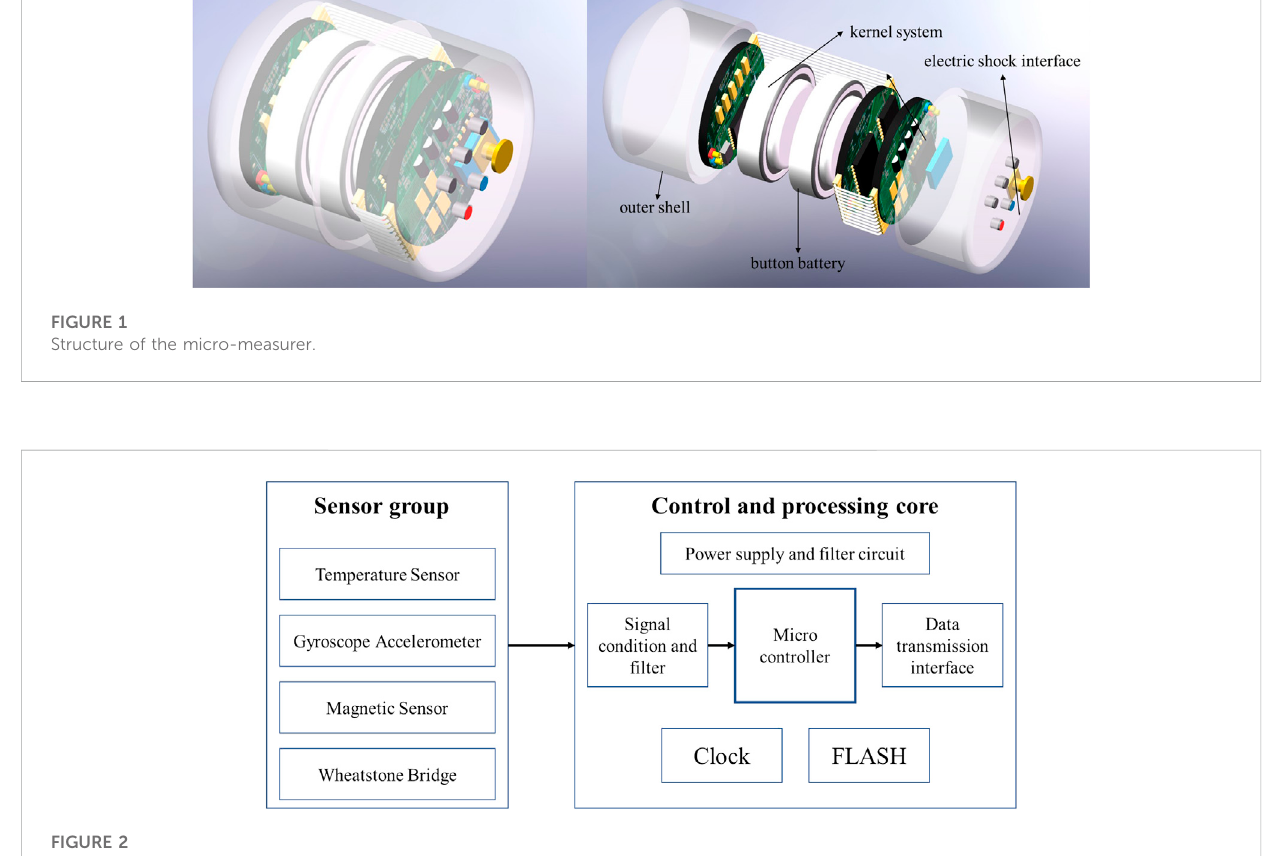
Hardware schematic of the kernel circuit